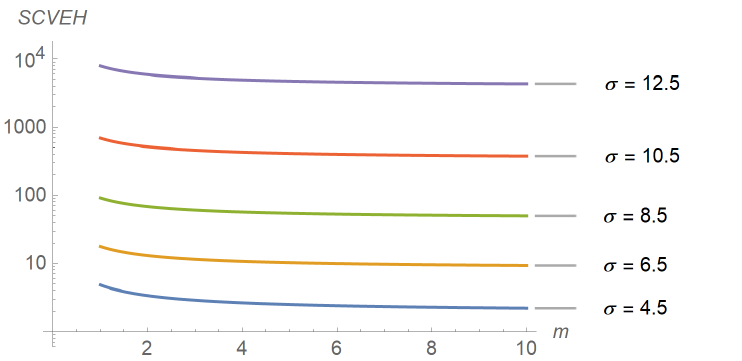
Figure 10. Evolution of the squared coefficient of variation as a function of the Nakagami parameter, for different values of the shadowing spread. The transmission distance and the path-loss exponent have been set to 50,000 m. and 3.0,